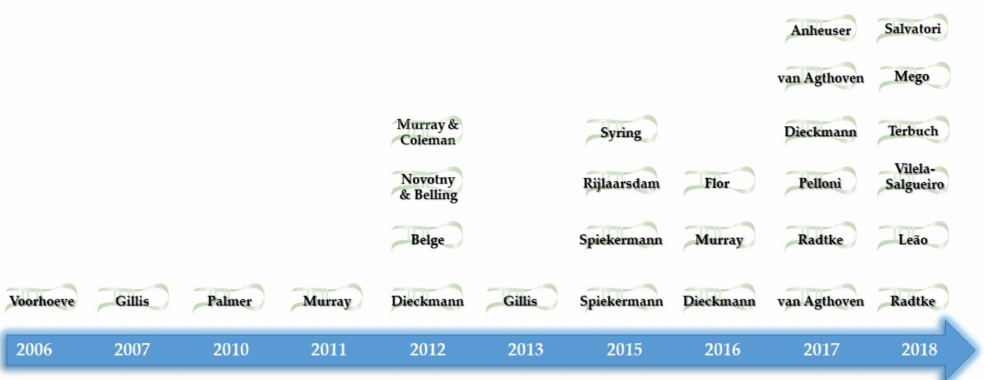
Figure 3. Chronological view of most relevant publications regarding microRNAs in testicular germ cell tumors (see text for